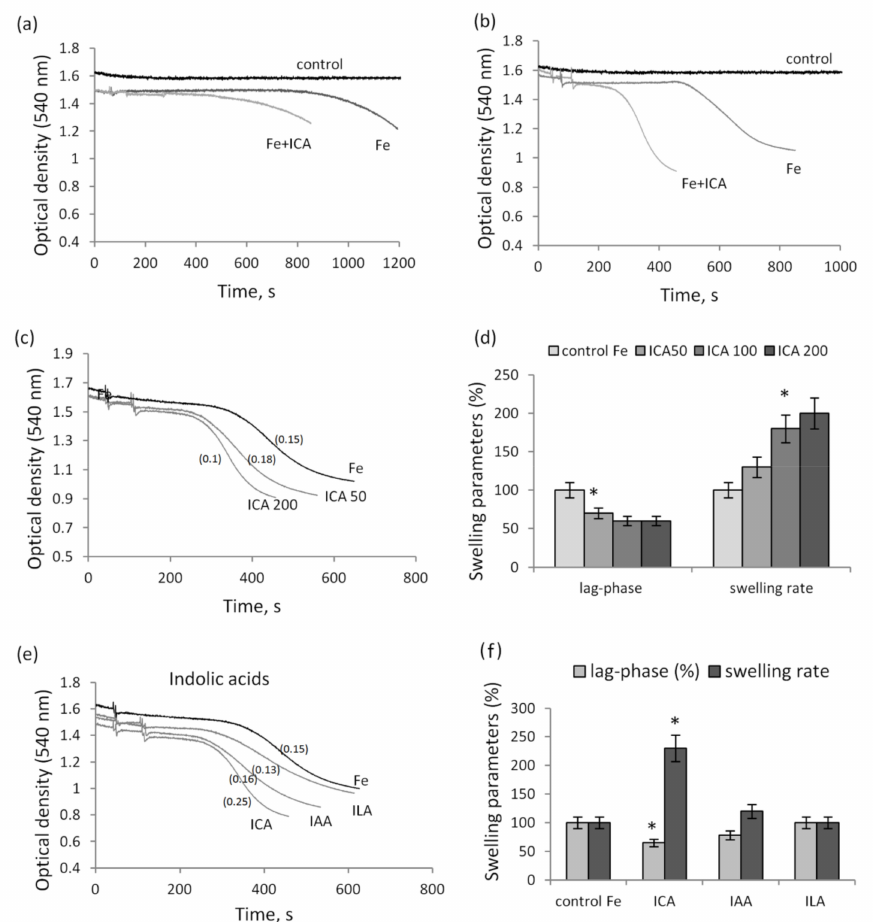
Figure 2. Influence of indolic acids on the mitochondrial swelling activated by iron ions. Activation of swelling during incubation with iron ions (50 µ M FeSO 4 ) and 100 µ M ICA ( a , b ) and at different ICA concentrations ( c ); changes in the swelling parameters in the presence of different ICA concentrations ( d ). The influence of indolic acids on swelling ( e ) and the swelling parameters: the lag phase and the swelling rate ( f ). The swelling rate ( ∆ /min) is indicated in parentheses. Asterisk (*) indicates values that differ significantly from the control values ( p <